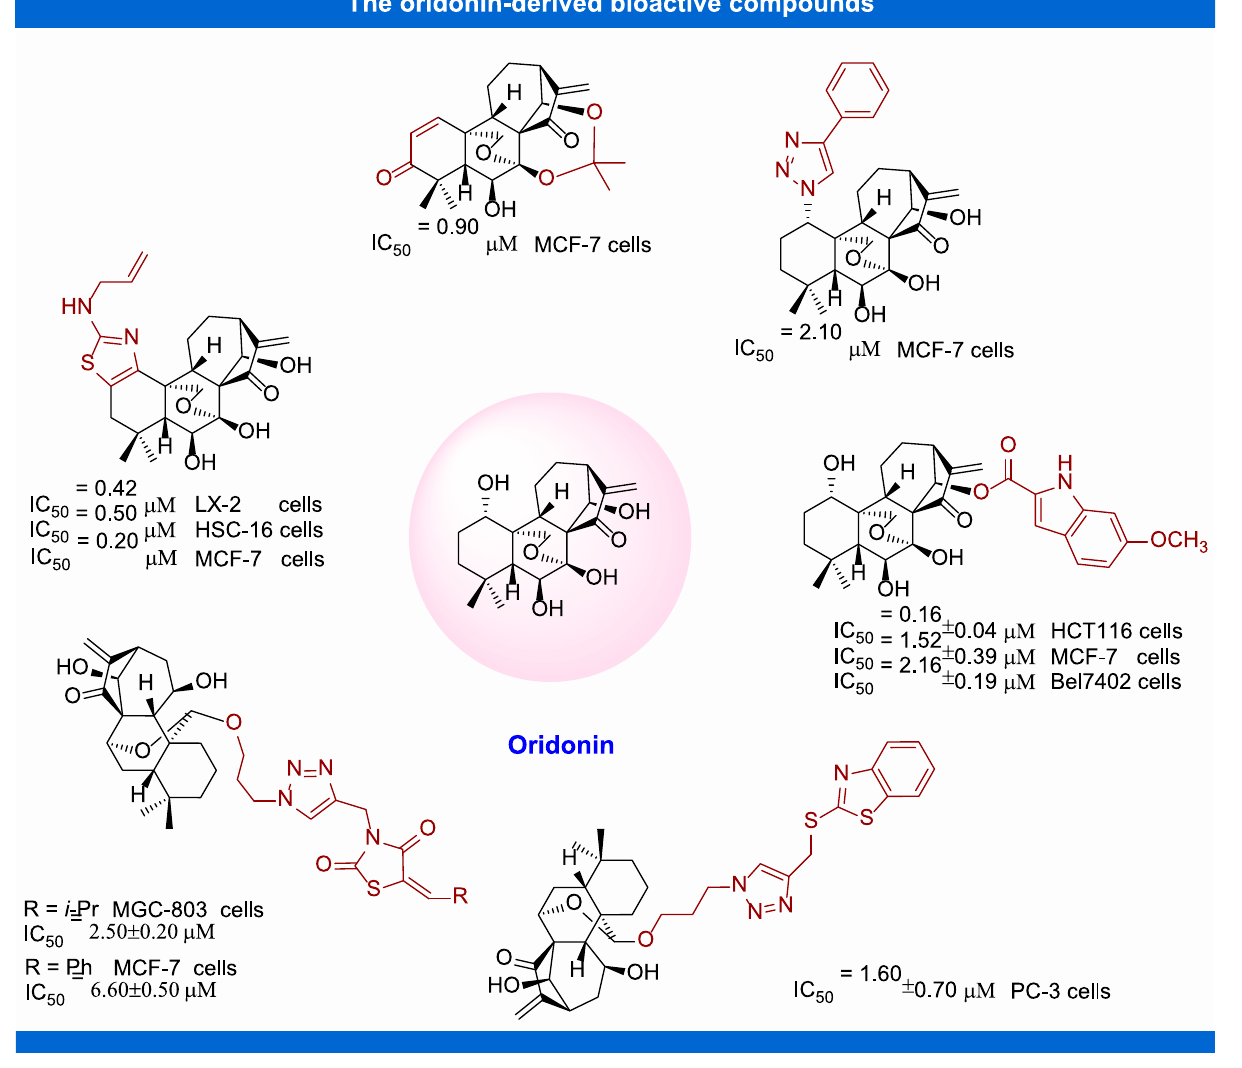
FIGURE 4 | The structural modi fi cation of oridonin.